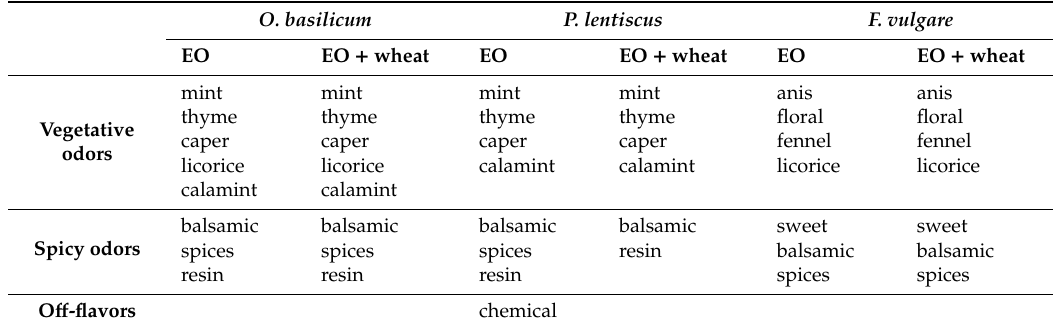
Figure 1. Essential oils (EOs) and EOs-aromatized wheat sensorial description. Sensorial descriptors were ranked by panel components on a 0 to 10 scale. Histograms represent the mean of the ranks. ( a ) sensorial descriptors of the EO of Foeniculum vulgare , Ocimum basilicum , and Pistacia lentiscus ; ( b ) sensorial descriptors of the EOs-aromatized wheat. Data represent the mean values of the smell ranks as assessed by the panelists. Bars represent the standard error. Different letters indicate significant difference among the treatments according to Tukey’s b post-hoc test ( p < 0.05). Table 2. The main odors that characterized the smell of the essential oils of Pistacia lentiscus , Ocimum basilicum , and Foeniculum vulgare , alone and added to the wheat.